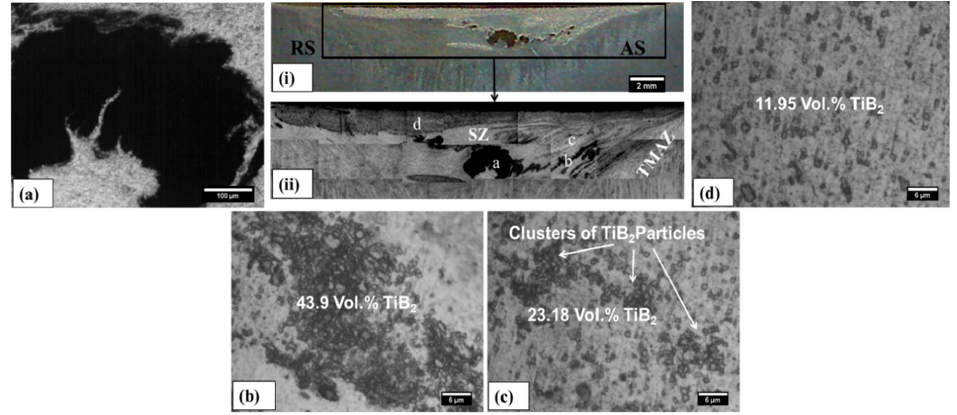
Figure 10. ( i ) Macro-image of cross-section of Sample 4. ( ii ) Microstructure of cross-section of the rectangle in macro-image showing: ( a ) agglomerated region; ( b ) mixed and Partially mixed region; and ( c , d ) dispersed regions.